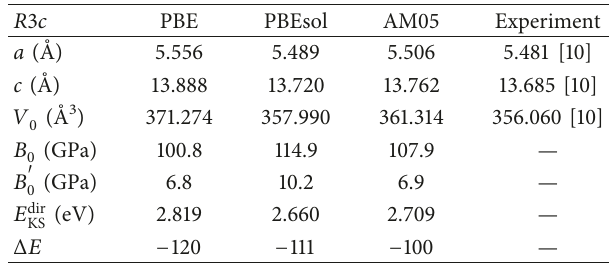
Figure 6: NaNbO 3 dielectric functions for the crystalline phases at room temperature and below calculated using the PBEsol functional revised for solids [18] (solid lines). The real (green) and imaginary (orange) parts of the dielectric functions for (a) the rhombohedral R 3 c phase (SG 161), (b) the orthorhombic Pbcm phase (SG 57), and (c) the monoclinic Pm phase (SG 6) are shown. For easier comparison, the dielectric functions of the high-temperature cubic perovskite Pm 3 m phase (SG 221) are included in (d). In addition, PBE0 hybrid functional calculations based on the PBEsol ground state structures are shown with dashed lines. Table 3: Structural properties of the orthorhombic Pbcm phase of Table 4: Structural properties of the rhombohedral R 3 c phase of NaNbO 3 . NaNbO 3